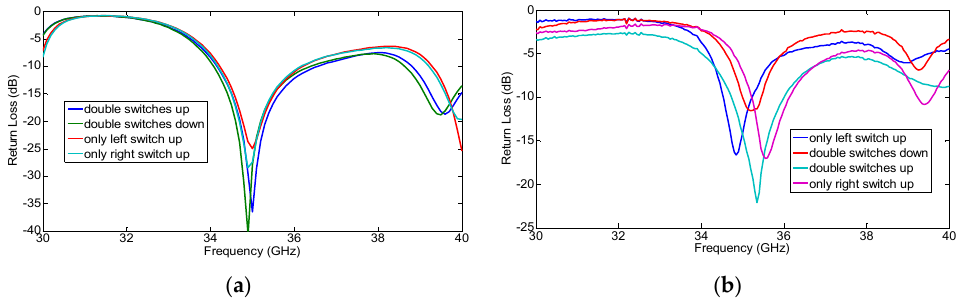
Figure 8. The measured return losses of all modes. ( a ) Simulation; ( b ) Measurement.